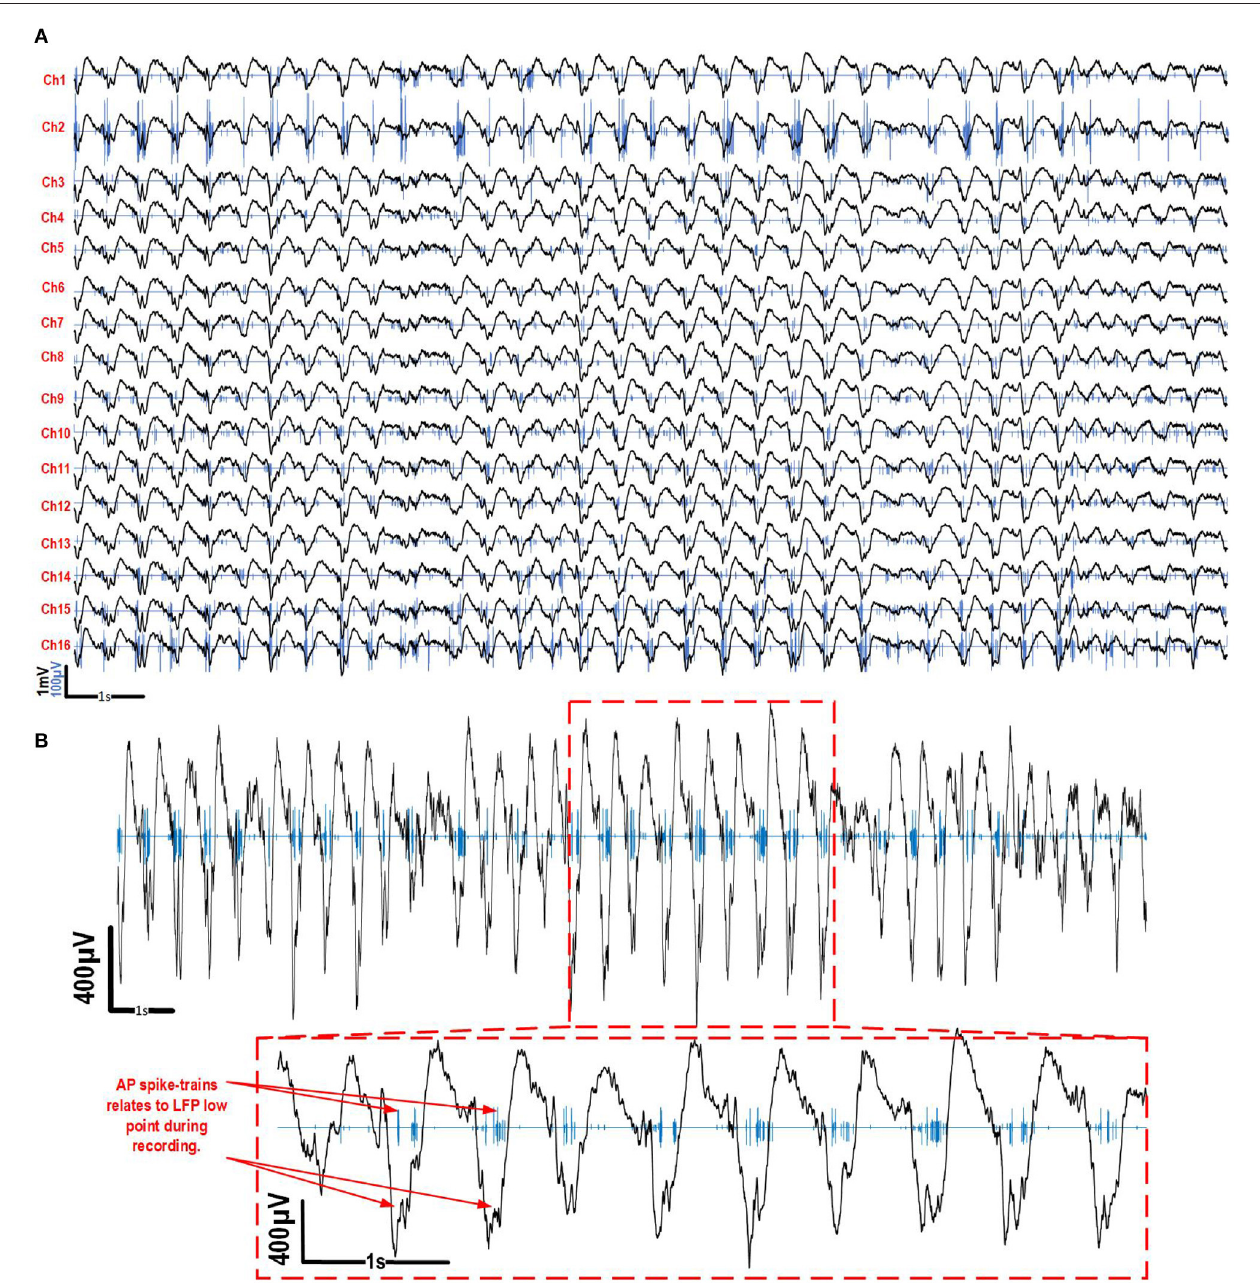
FIGURE 7 | In vivo recordings for 16 channels of both LFP and AP in the brain of a freely moving Long-Evans rat under anesthesia. (A) 20 s of recording during the experiment with the AP and LFP superimposed. (B) A magnification of the signals on channel two during the same recording to highlight the correspondence between AP spike-trains and LFP